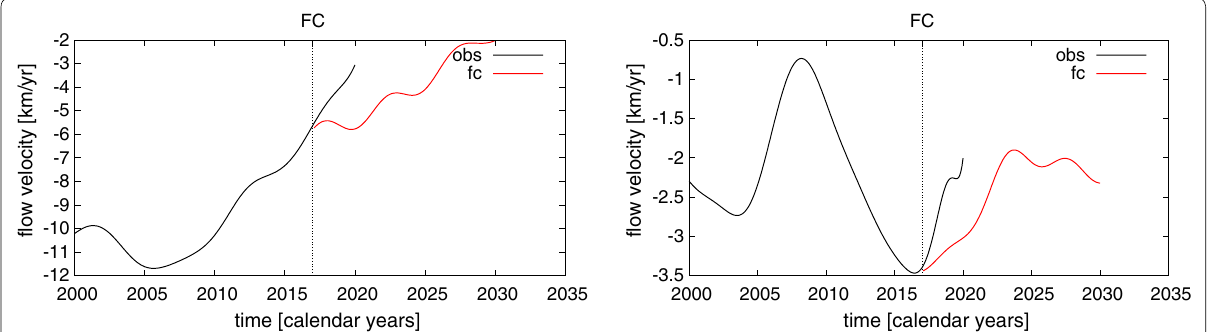
Fig. 9 Evolution of the toroidal flow coefficients t 0 1 (left) and t 0 3 (right); their past variations (black) and their forecasts (red) based on the MSSA. The vertical line labeled with FC marks the start of the forecast